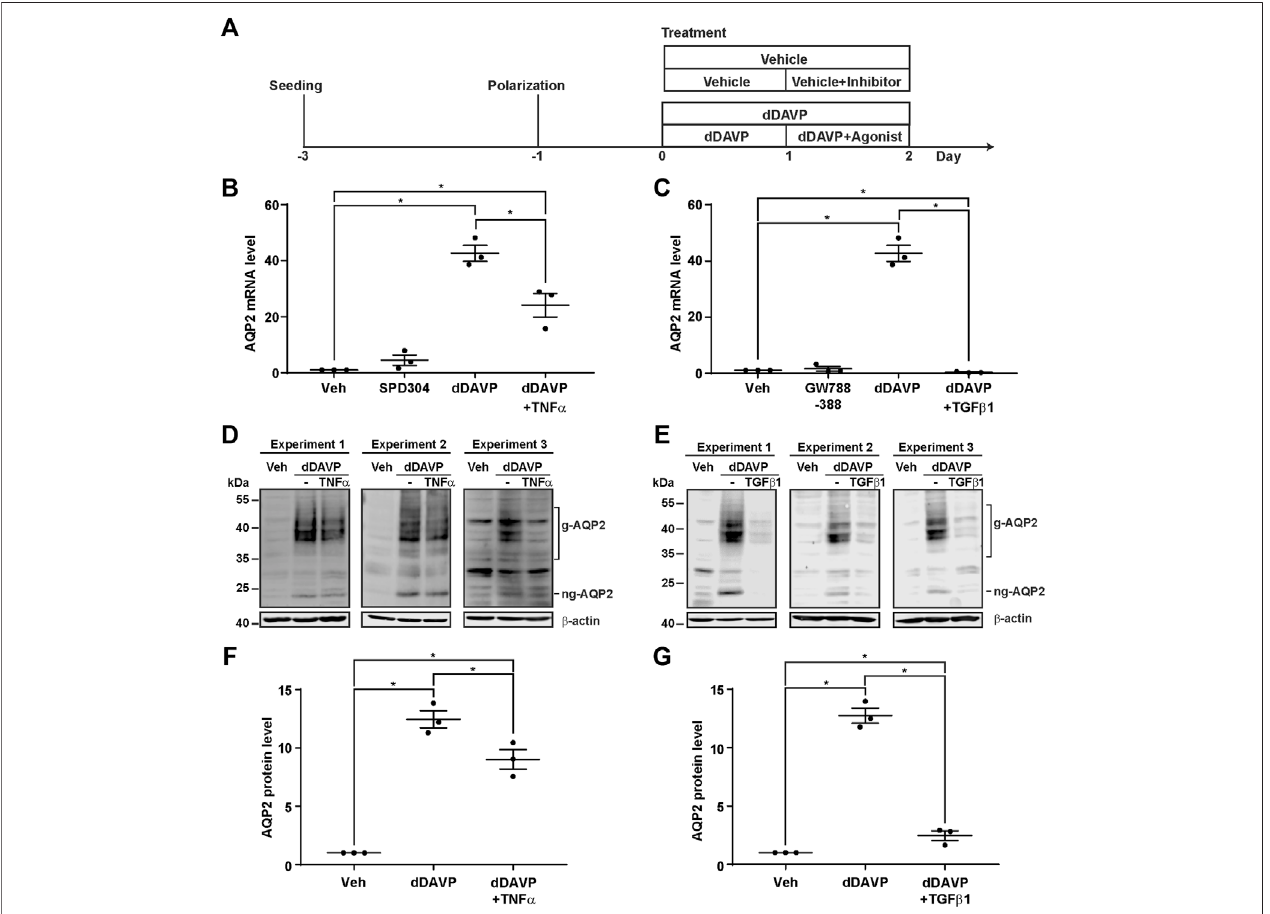
FIGURE 5 | TNF α and TGF β 1 reduced the vasopressin-induced Aqp2 gene expression. (A) Experimental protocol. (B,C) Quantitative RT-PCR measurements of the AQP2 mRNA level in the mpkCCD cells exposed 24 h to the TNF receptor inhibitor (100 nM SPD304), TGF β receptor inhibitor (10 μ M GW788388), dDAVP (1 nM), dDAVP +TNF α (40 ng/ml), ordDAVP+TGF β 1(10 ng/ml). (D,E) Immunoblotsand (F,G) summaries ofimmunoblottingresultsfortheAQP2protein levelinthempkCCD cells under the same conditions as for AQP2 mRNA measurements. Values are mean ± S. E. summarized from three independent experiments. Values were normalized with loading control ( β -actin) before being compared against those under the vehicle conditions. Asterisks indicate statistical signi fi cance ( p < 0.05, t -test). g-AQP2, glycosylated AQP2; ng-AQP2, non-glycosylated AQP2; Veh, vehicle.